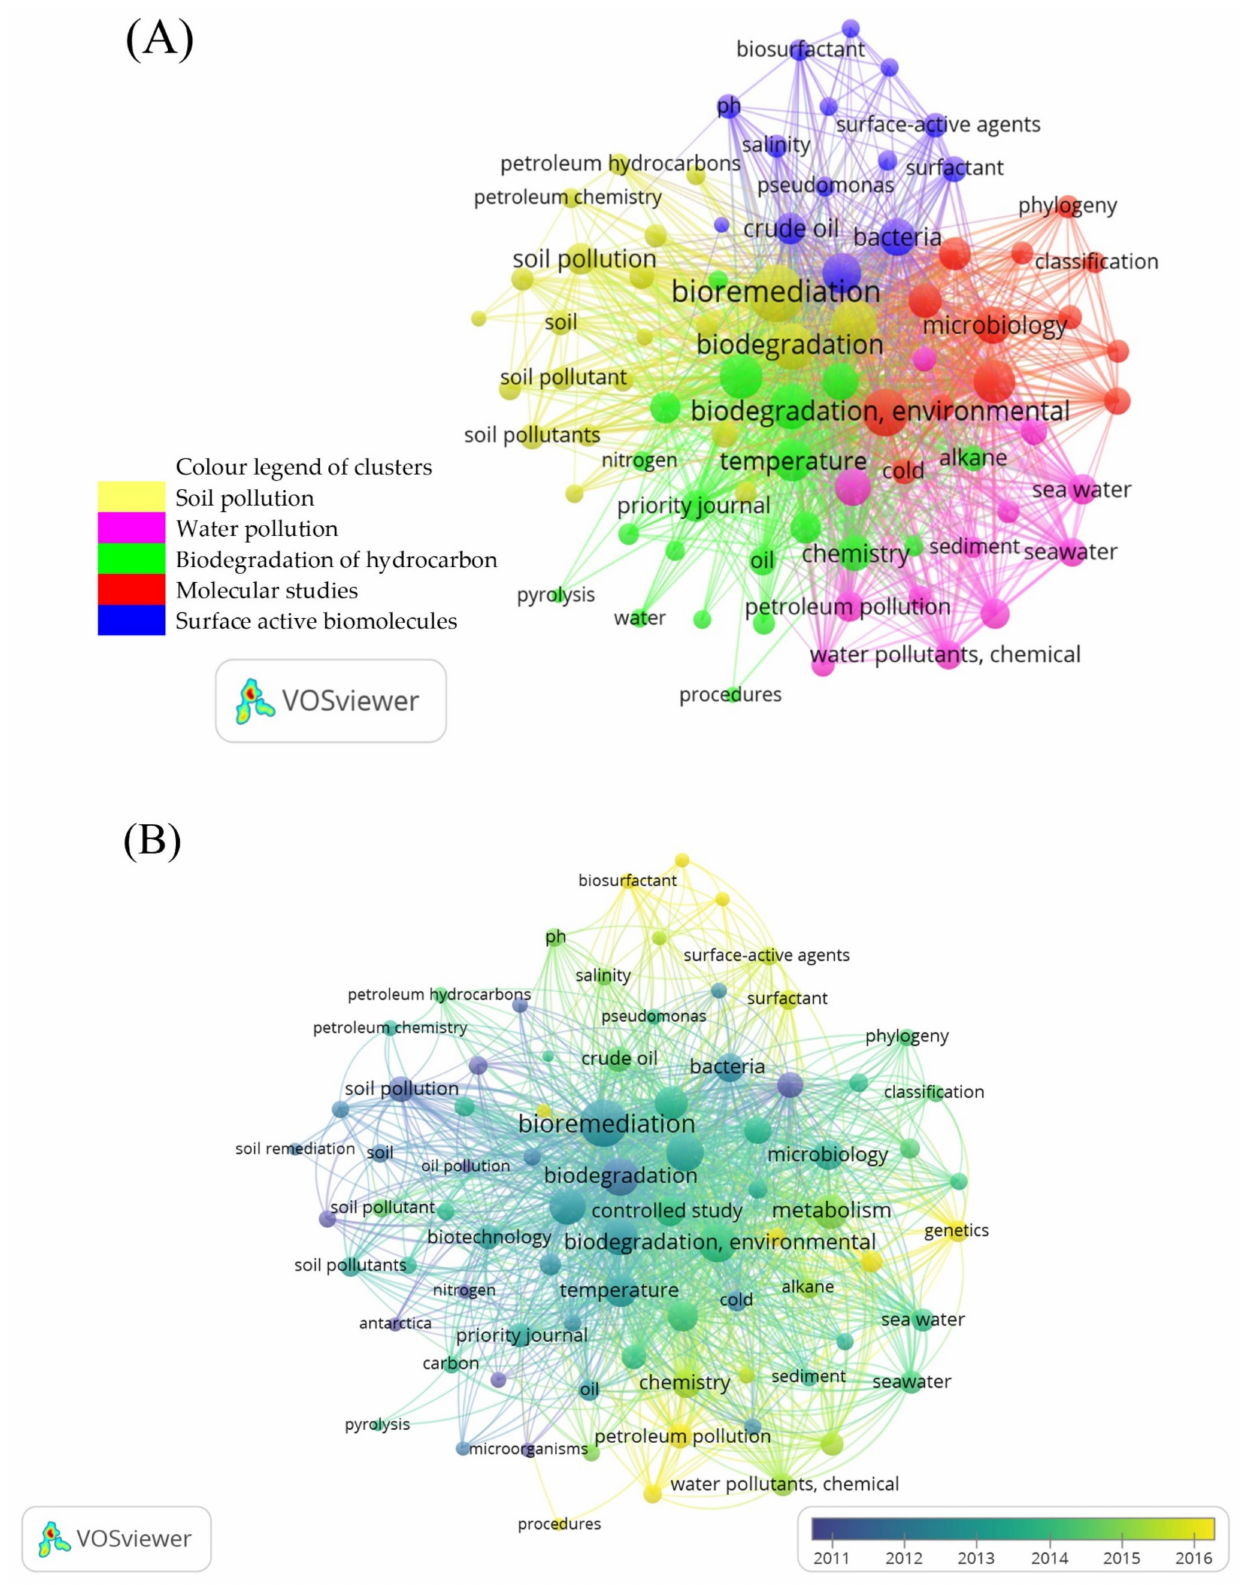
Figure 2. Analysis of keywords. ( A ) Network visualisation of keyword co-occurrence based on total link strength between 90 generated keywords. ( B ) Overlay visual of keyword distribution across average publication